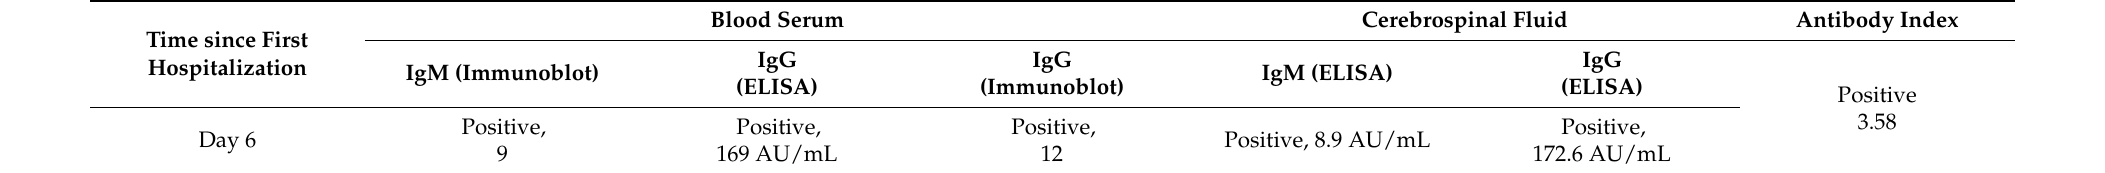
Table 2. Laboratory analysis— Borrelia burgdorferi